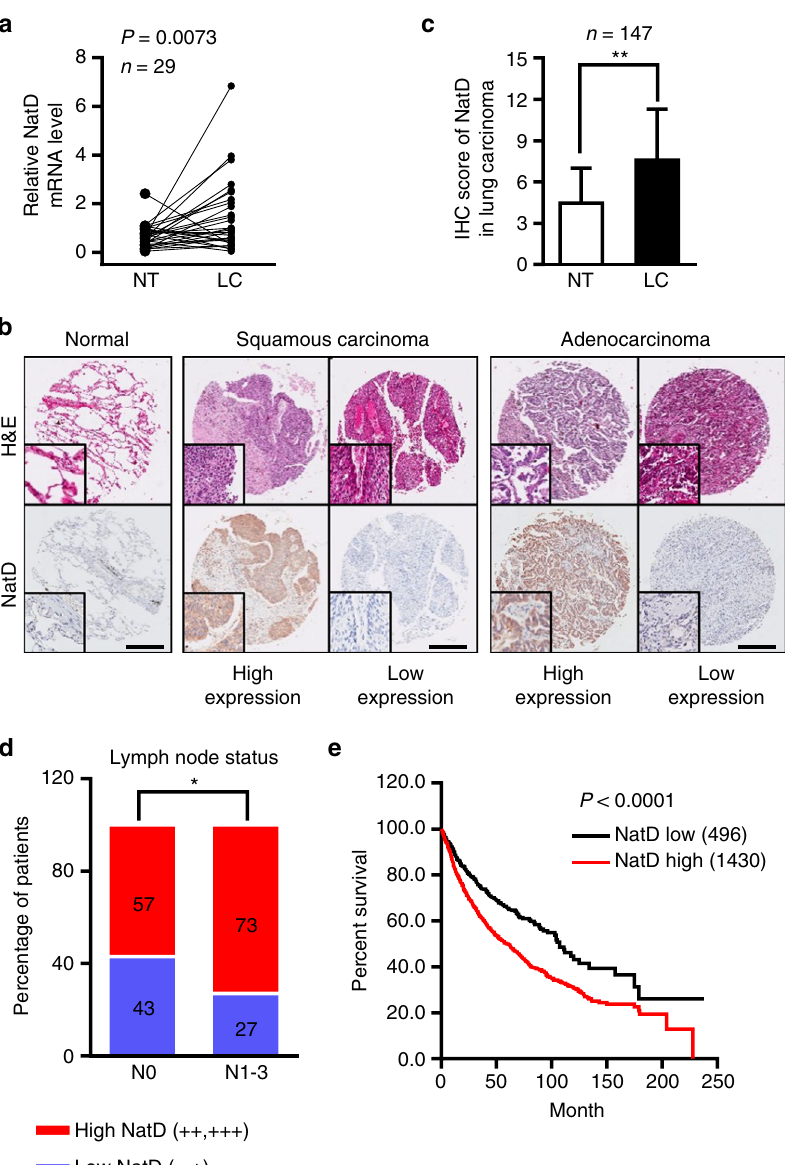
Fig. 1 Upregulation of NatD in lung tissues correlates with enhanced invasiveness and poor prognosis of patients with lung cancer. a Quantitative real-time PCR analysis of NatD mRNA levels normalized to GAPDH in lung carcinoma (LC) and matched normal tissues (NT); n = 29, two-tailed Student ’ s t -test; P = 0.0073 compared with matched normal tissue control. b Representative images of H&E staining and immunohistochemical (IHC) staining of NatD in matched normal tissues ( n = 147), human lung squamous carcinoma ( n = 74), and lung adenocarcinoma ( n = 73) tissue samples. Scale bars , 500 μ m. c Total IHC score of NatD in matched normal tissues (NT) and lung carcinoma (LC); mean ± s.d. of 147 pairs of tissue samples; two-tailed Student ’ s t -test, ** P < 0.01 compared with matched normal tissue control. d Percentage of lung cancer patients with high expression and low expression of NatD strati fi ed according to lymph node status (N0 or N1 – 3) ( n = 147); two-sided Pearson χ 2 test, * P < 0.05. e Kaplan – Meier plots of overall survival of patients with lung cancer, strati fi ed by NatD expression. Data were obtained from Kaplan – Meier plotter database 49 ; log-rank test, P <